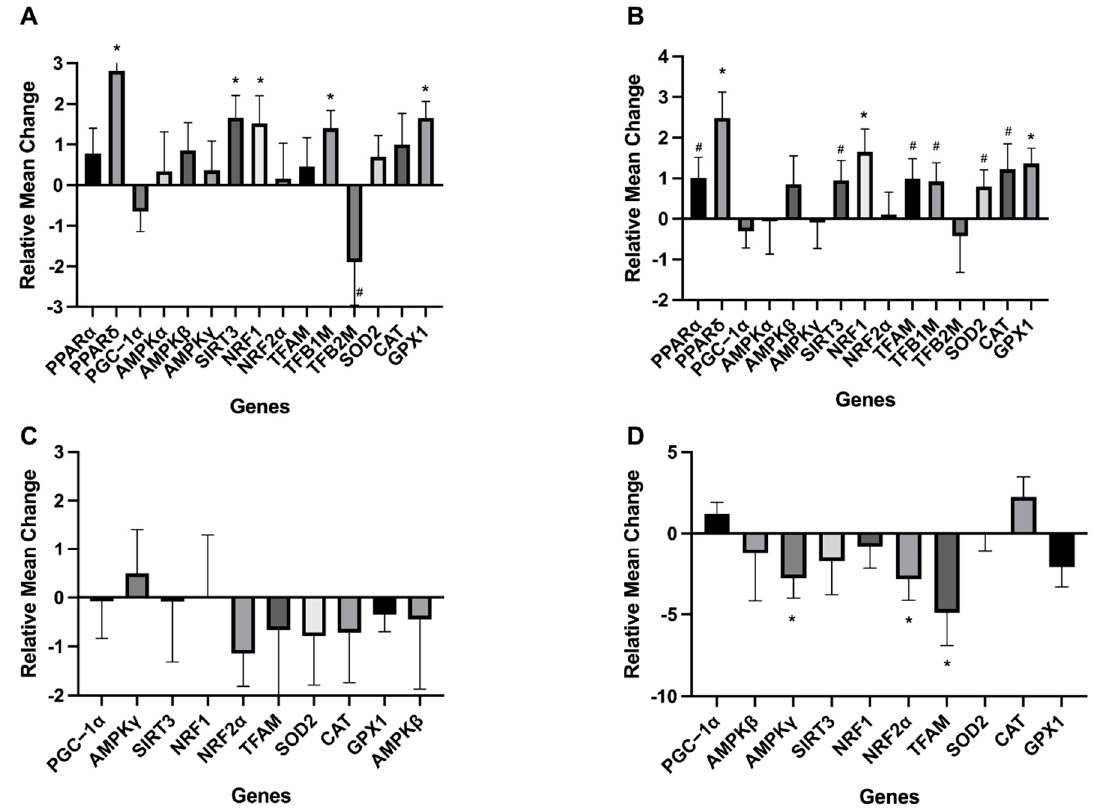
Figure 4. Changes in liver and skeletal muscle gene expression across lactation. Mean changes represent expression levels at peak or late lactation relative to early lactation: ( A ) gene expression in liver at peak lactation, ( B ) gene expression in liver at late lactation, ( C ) gene expression in skeletal muscle at peak lactation, ( D ) gene expression in skeletal muscle at late lactation. * denotes p < 0.05 and # denotes p < 0.10 and > 0.05. Expression of PPAR α , PPAR δ , AMPK α , TFB1M , and TFB2M were undetectable in skeletal muscle and thus are not presented here.